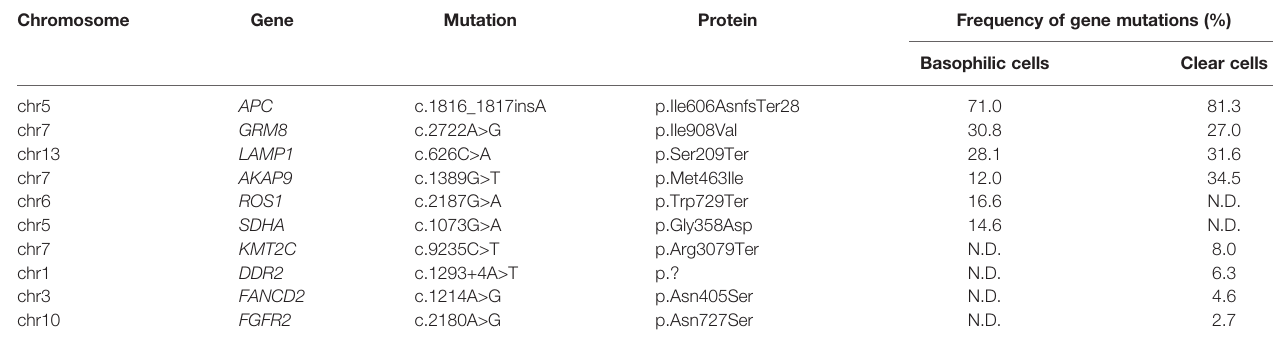
TABLE 2 | Gene mutations determined by Comprehensive Cancer Panel. Chromosome